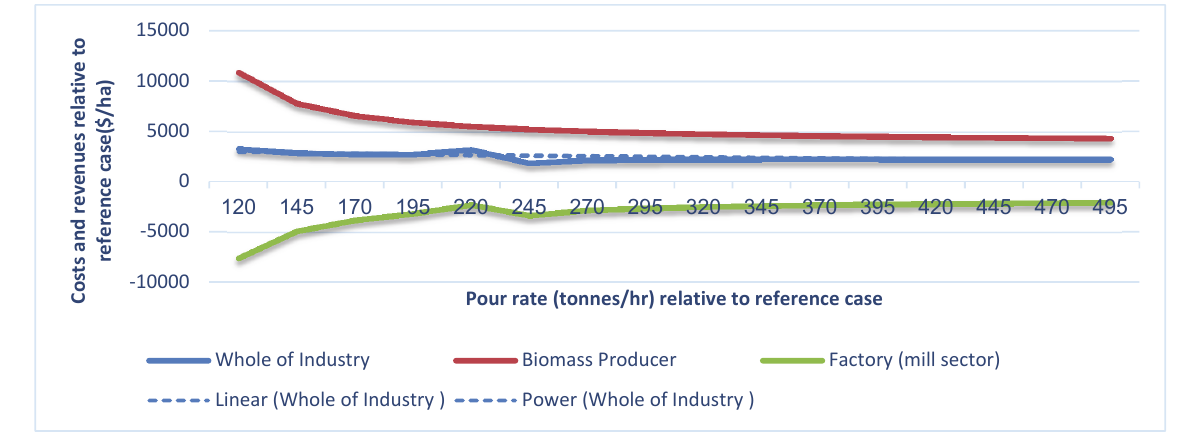
Fig. 8 . Effect of Changes of relative Pour rate on industry sector relative return